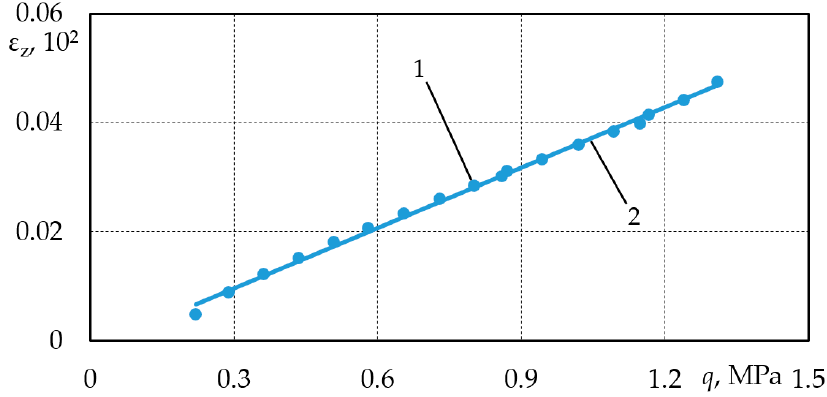
Figure 15. Summary experimental data: 1—experimental data and 2—generalized line.